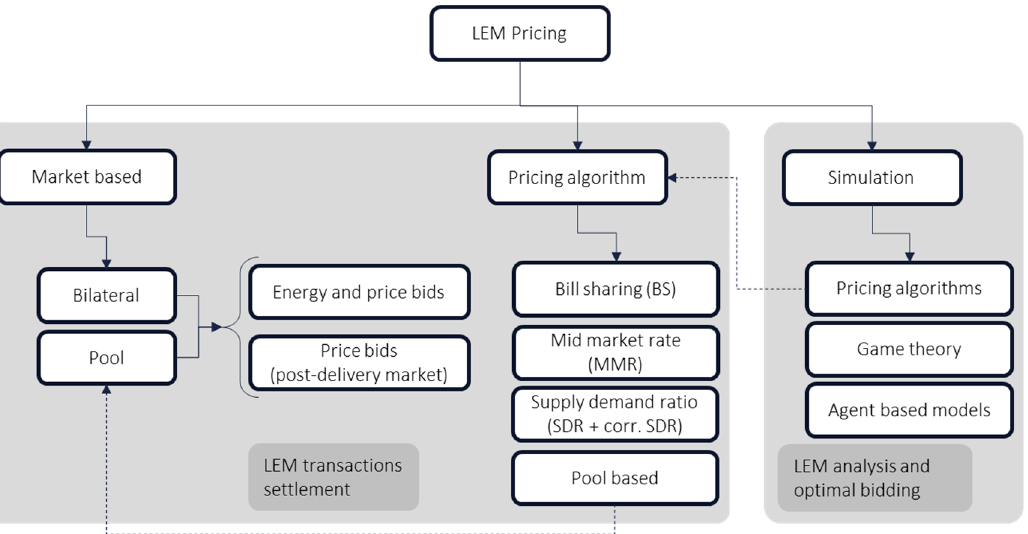
Figure 3. Classification of LEM pricing mechanisms.